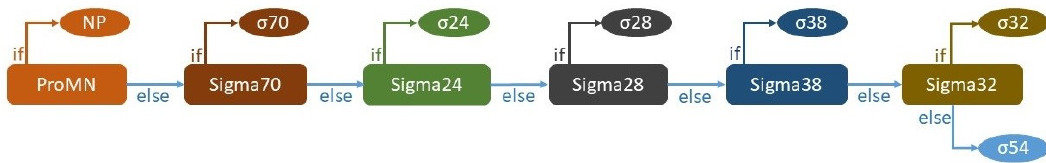
Figure 2. Model overview of pcPromoter-CNN. Table 2. Cascade binary classifiers.